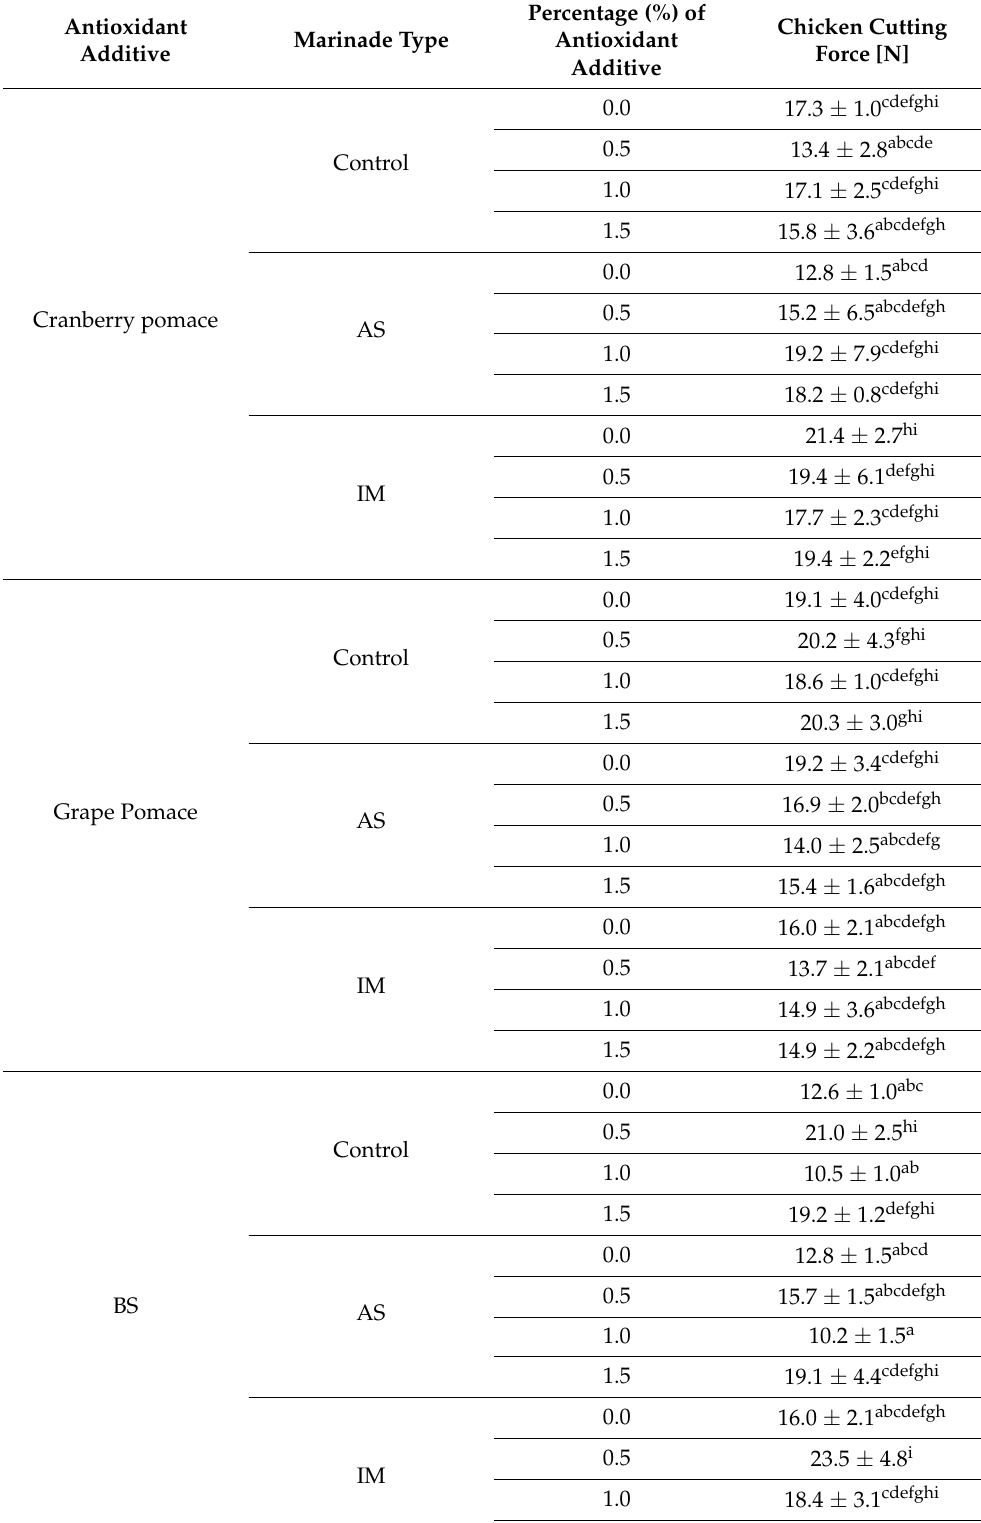
Table 4. Changes in textural cutting force across the various marinated oven-grilled chicken breast meat samples compared to